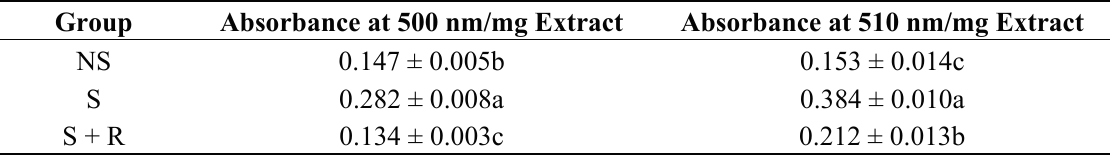
Table 1. Content of condensed tannins in the extracts.